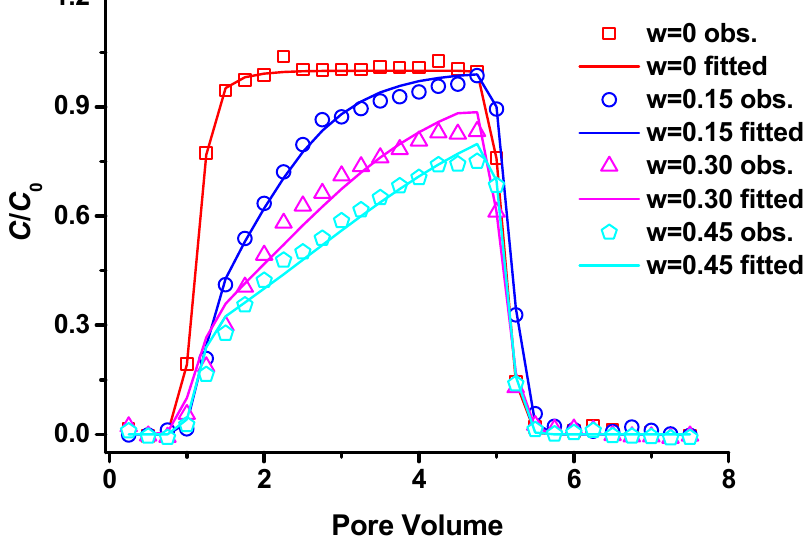
Figure 2. Observed (dots) and simulated (solid lines) breakthrough curves (BTCs) of GO under different Fe oxide fractions ( ω = 0 ‒ 0.45) at pH = 5.0 and IS = 1.0 mM KCl. Symbols are experimental data and solid lines are the fitted results obtained from the two-site kinetic attachment model.